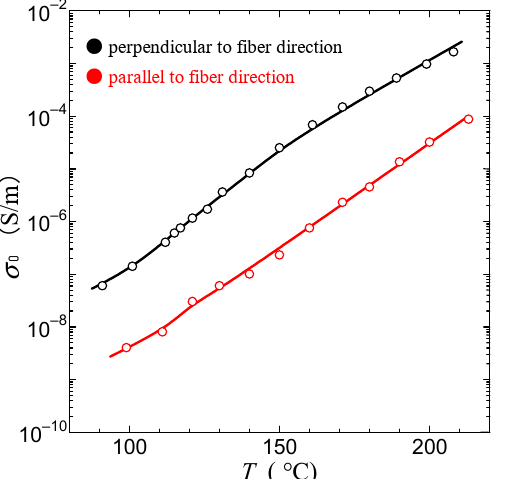
Figure 10. Proton-conductivity pathway in the imidazole–collagen composite ( n = 2.0). ( a ) Schematic of the imidazole-collagen composite. ( b ) Proton conduction pathway of activated imidazole- collagen composite.